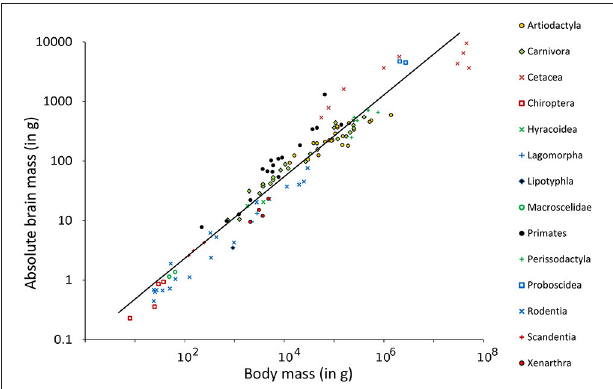
FIGURE 2 | Double logarithmic plot of absolute brain mass (AB) above body mass (BM) including regression line of 115 species of Eutheria arranged by order relationships (Figure